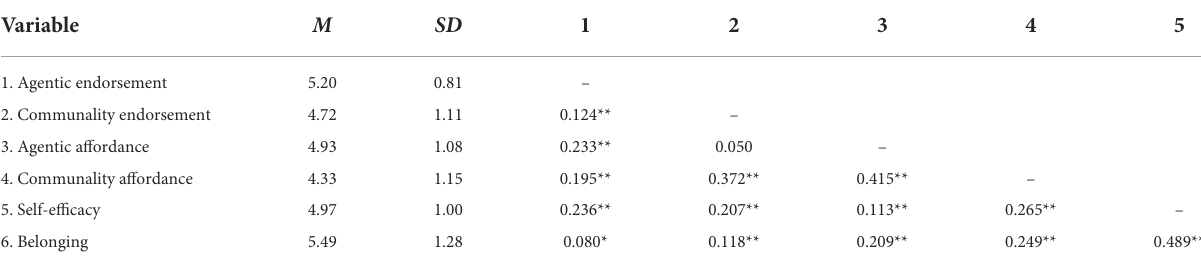
TABLE 4 Means, standard deviations and correlations between main variables. Variable